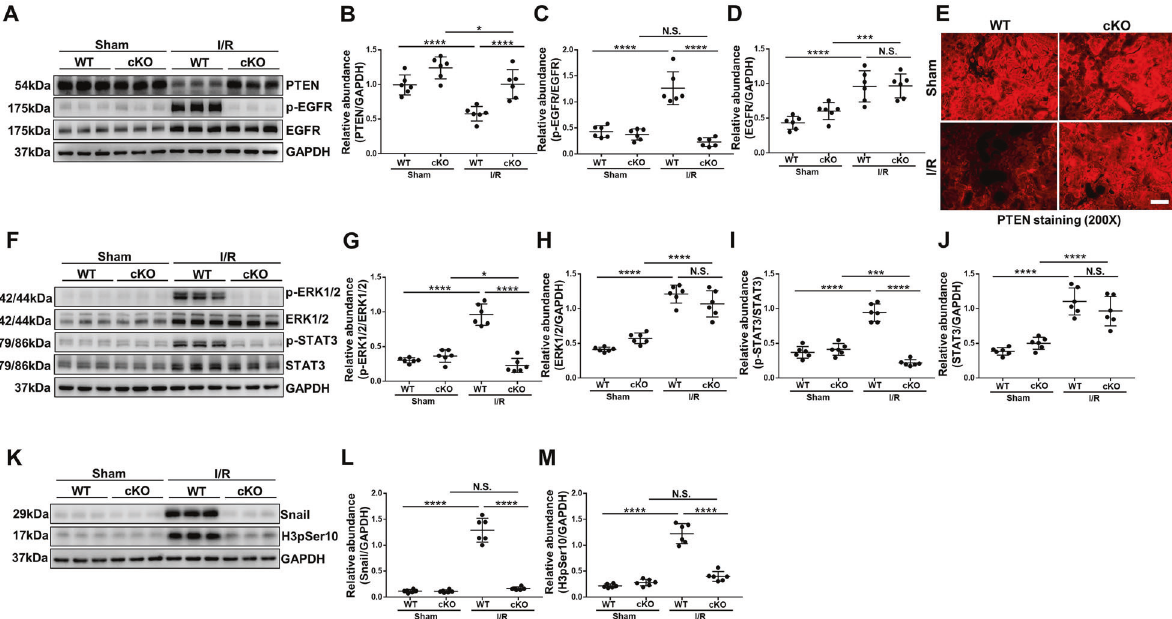
Fig. 4 EZH2 conditional knockout upregulates the expression of PTEN, thus blocking the activation of EGFR/ERK1/2/STAT3 signaling pathway in I/R induced AKI-to-CKD transition mouse model. A Kidney tissue lysates from I/R mice were prepared and subjected to immunoblotting analysis with antibodies against PTEN, p-EGFR, EGFR, and GAPDH. B – D Expression levels of PTEN, p-EGFR, EGFR in different groups were quanti fi ed by densitometry and normalized with GAPDH and EGFR respectively. E Photomicrographs showed the immuno fl uorescent staining of PTEN in different groups. F Kidney tissue lysates from I/R mice were prepared and subjected to immunoblotting analysis with antibodies against p-ERK1/2, ERK1/2, p-STAT3, STAT3, and GAPDH. G – J Expression levels of p-ERK1/2, ERK1/2, p- STAT3, STAT3 in different groups were quanti fi ed by densitometry and normalized with GAPDH, ERK1/2, and STAT3, respectively. K Kidney tissue lysates from I/R mice were prepared and subjected to immunoblotting analysis with antibodies against Snail, H3pSer10, and GAPDH. L , M Expression levels of Snail and H3pSer10 in different groups were quanti fi ed by densitometry and normalized with GAPDH. Data were expressed as means ± SEM. * P < 0.05; ** P < 0.01; *** P < 0.001; **** P < 0.0001. N.S., statistically not signi fi cant, with the comparisons labeled. All scale bars = 50 μ